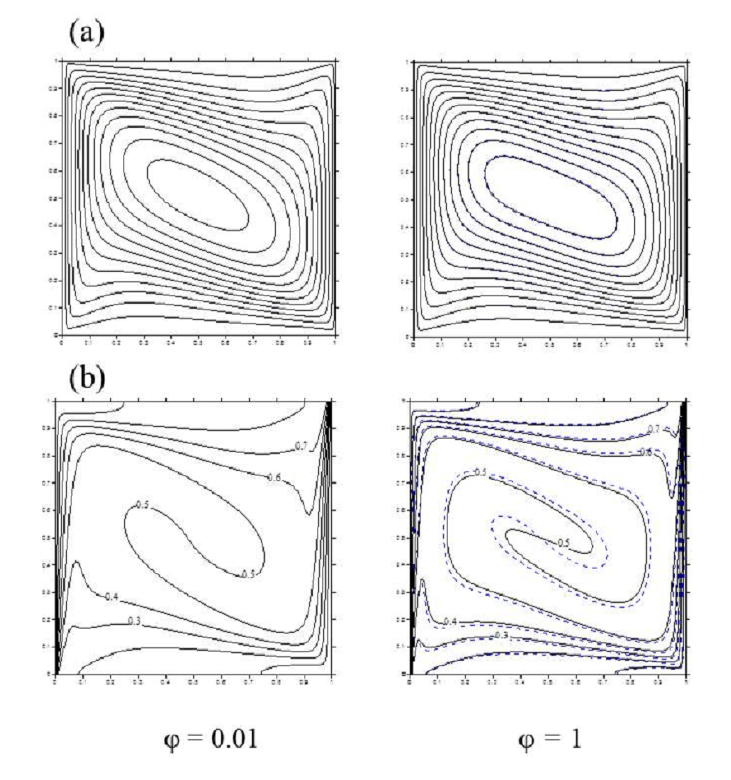
Figure 3: Streamlines (a) and Isotherms (b) of the nanofluids for different values of the solid volume fraction. Ri = 1 ,[ — Cu-water, — Ag- water